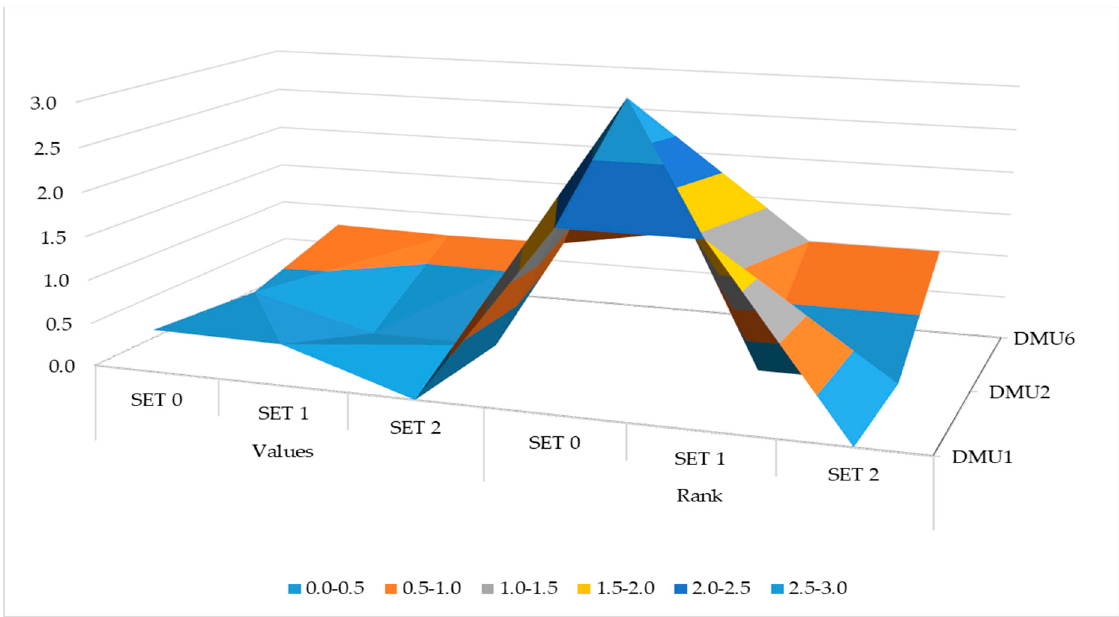
Figure 6. Values and ranks of DMUs using the fuzzy SAW, fuzzy WASPAS, and fuzzy TOPSIS methods.